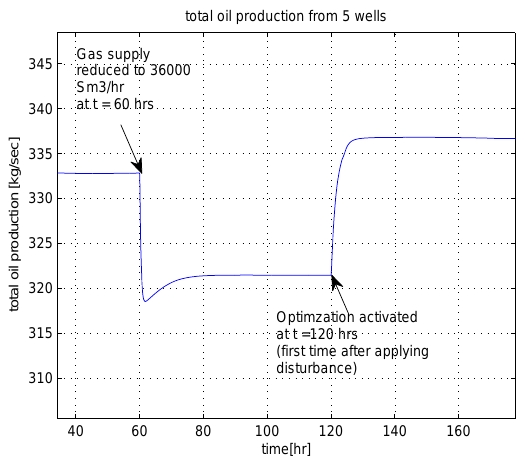
Figure 11: Total oil production when optimization was performed for the (cid:28)rst time, only after input disturbance was